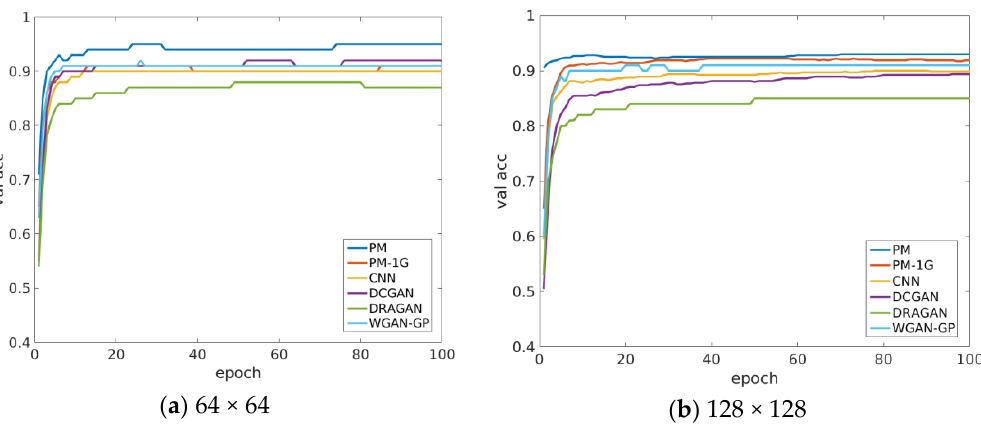
Figure 8. The comparison of the proposed recognition network (PM), supervised CNN, DCGAN, DRAGAN, and WGAN-GP: average validation accuracy for ( a ) 64 × 64 and ( b ) 128 × 128 MSTAR dataset, respectively.